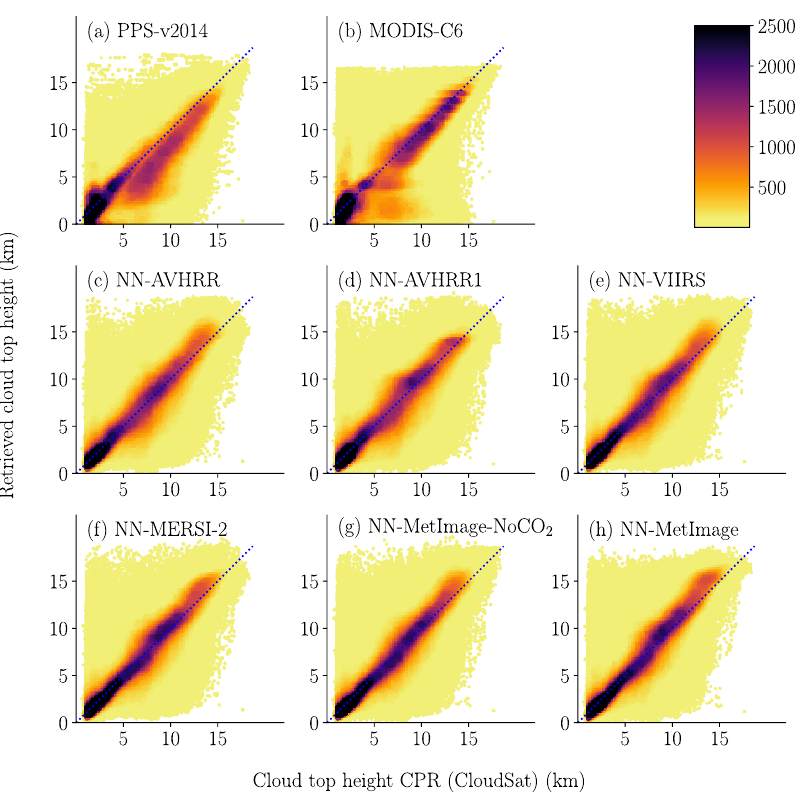
Figure 2. Scatters plot of the height for the neural networks and for the reference methods against CPR (CloudSat) height. The data were divided in 0.25 × 0.25(km) bins for color coding. The number of points in each bin determines the color of the point. The final validation dataset (see Table 1) where all algorithms had a height reported is used. Two points where CPR (CloudSat) had a height above 22km where excluded. A cloudy threshold of 30% is used for CPR (CloudSat).